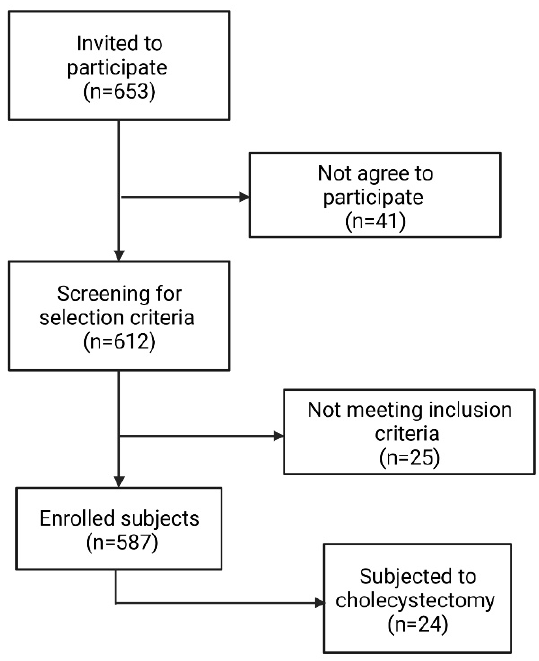
Figure 1. Flowchart for recruitment of the subjects.